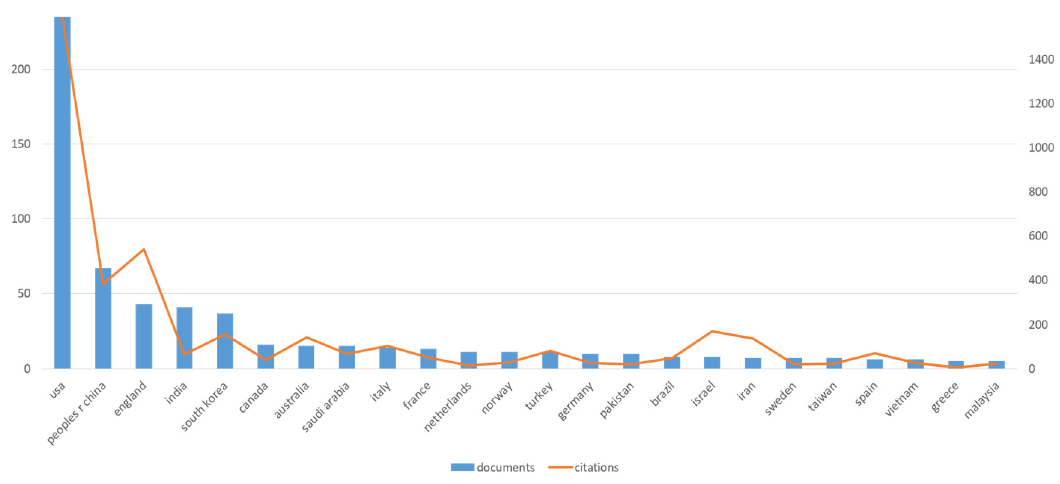
Figure 15. Country analysis; Most important by documents and citations.